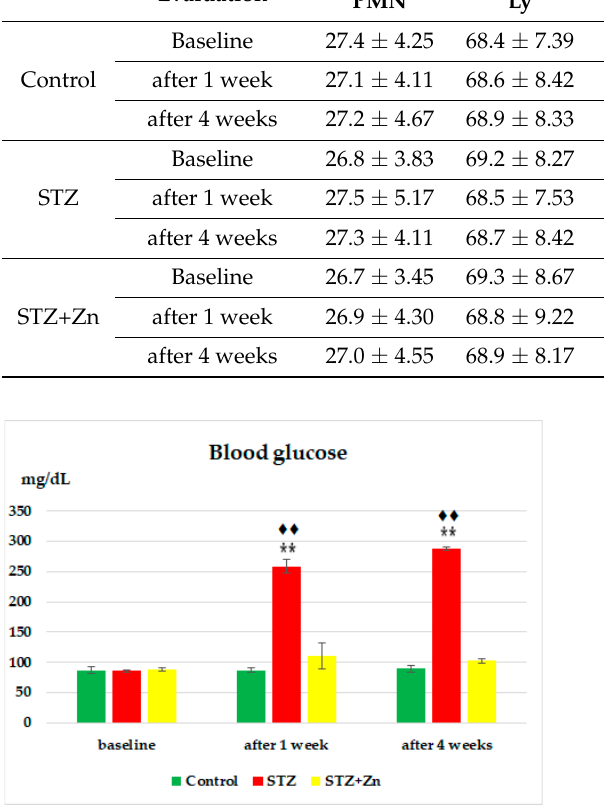
Figure 2. The effects of Zn on the glycemia values in diabetic rats. The values are presented as arithmetic average ± S.D. for five animals in a group. ** p < 0.01 versus control; ♦♦ p < 0.01, versus baseline.